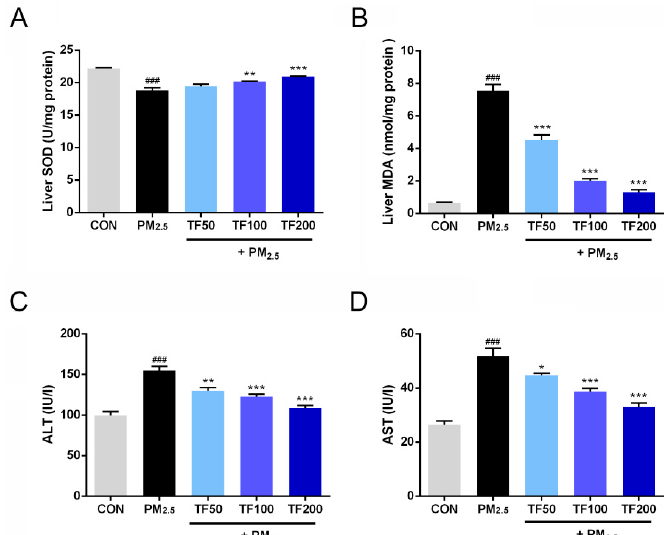
Figure 4. Effects of TF administration on oxidative stress and liver injury in PM 2.5 induced NAFLD. The levels of superoxide dismutase (SOD) ( A ), malondialdehyde (MDA) ( B ) in the liver, alanine aminotransferase (ALT) ( C ) and aspartate aminotransferase (AST) ( D ) in the serum were measured in the following groups: control group (CON), PM 2.5 exposure group, PM 2.5 + TF 50 mg/kg group, PM 2.5 + TF 100 mg/kg group and PM 2.5 + TF 200 mg/kg group. All the results were presented as mean ± SE ( n = 10). ### p < 0.001 vs. the CON group; * p < 0.05, ** p < 0.01, *** p < 0.001 vs. the PM 2.5 group. Int. J. Mol. Sci. 2018 , 19 , x FOR PEER REVIEW